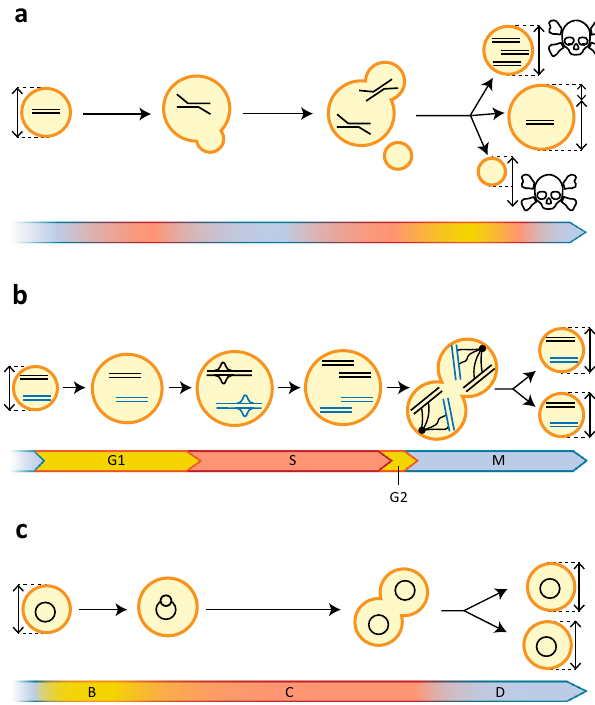
Fig. 5 Cell cycle in natural and synthetic cells. a In a synthetic cell that lacks control over DNA replication, DNA segregation and cell division, nothing prevents these processes from happening simultaneously, most likely leading to loss of cell-size homoeostasis, hyper-replicative stress, inconsistency in genomic content, and non-viability of daughter cells. b In eukaryotic cells, the passage through phases of the cell cycle is controlled by molecular checkpoints, depicted as bold lines separating the different phases. c In the bacterium Escherichia coli , the cell cycle lacks a eukaryotic- type checkpoint system. However, the order of the cell cycle phases is maintained through coupling with